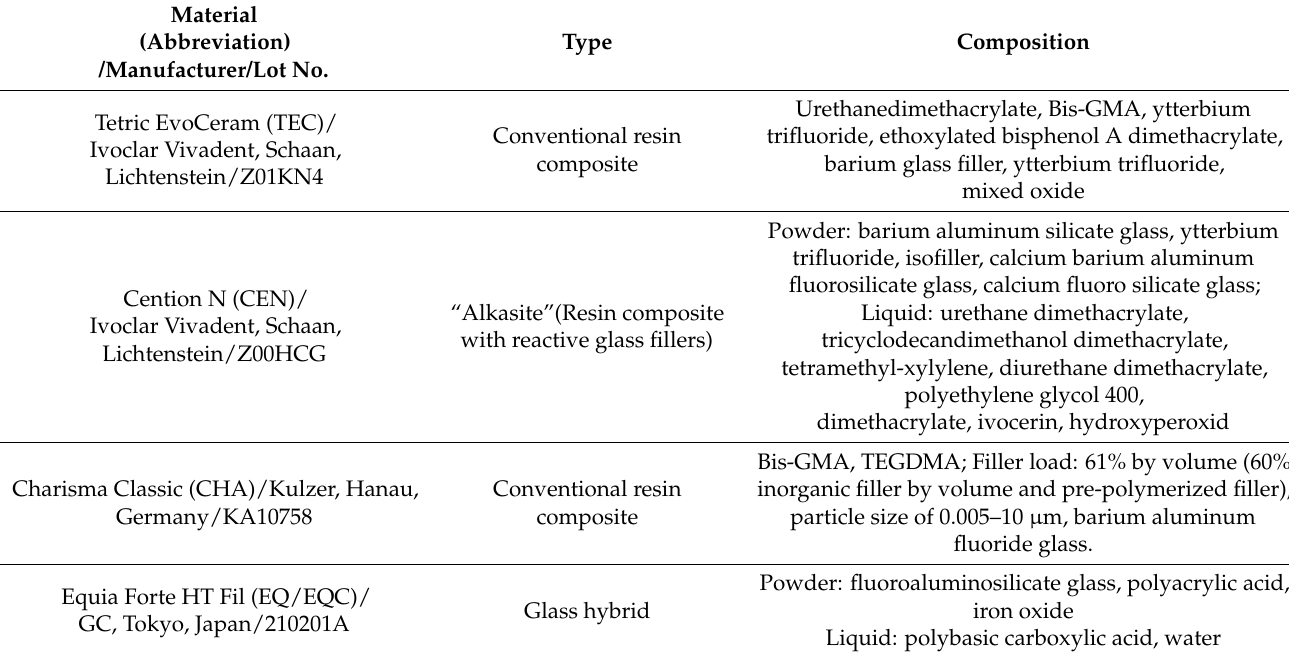
Table 1. Composition of tested materials provided by respective